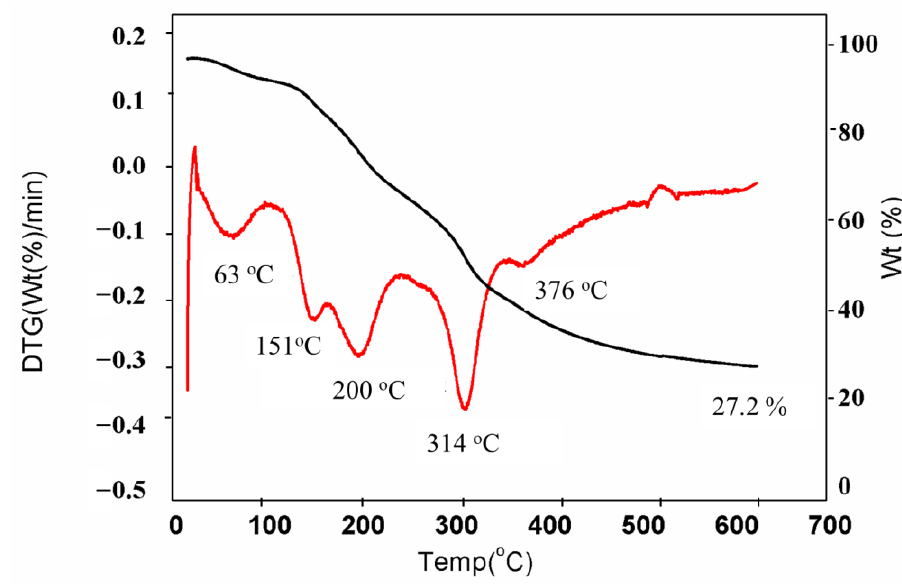
Figure 2. Thermogravimetric analysis of oven-dried cucumber.